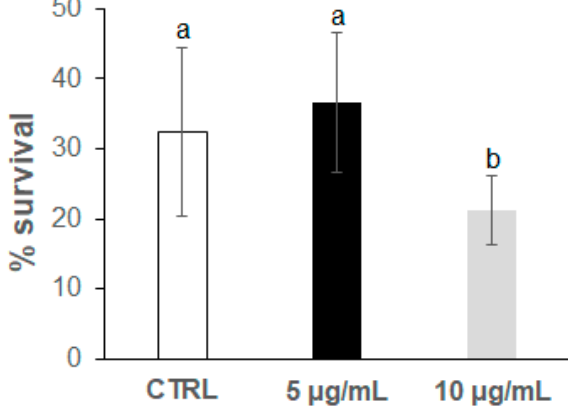
Figure 2. Percentages of worm survival at the 2nd day of adulthood after the application of thermal stress (35 °C, 8 h). The results were obtained in the C. elegans wild ‐ type N2 strain grown in the absence (controls) and presence of the bilberry anthocyanin extract at concentrations of 5 and 10 µ g / mL in the culture medium. The results are presented as the mean values ± SD. Different letters between bars indicate significant difference, p < 0.05.